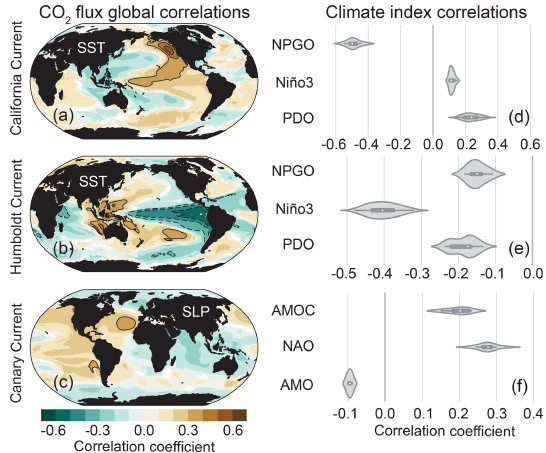
Figure 5. Correlations between area-weighted CO 2 flux anomalies in the statistical study regions outlined in black in Fig. 1 (e–g) and SSTa ( a–b ; California, Humboldt) and SLPa ( c ; Canary) grid cells globally. Brown colors indicate that positive SSTa and/or SLPa cor- relates with outgassing, and blue with uptake. Contour lines begin at ± 0 . 3 and progress in intervals of 0.1. Correlations were performed for each realization individually, and the ensemble mean of those global correlations are presented here. Violin plots display correla- tions between area-weighted CO 2 flux anomalies from (a) to (c) , with major modes of Pacific (d–e) and Atlantic (f) variability. The interior of the violin plot displays a box plot with the ensemble mean denoted as a white dot. Shading around the box plot reflects the ensemble distribution of correlations, which are mirrored on ei- ther